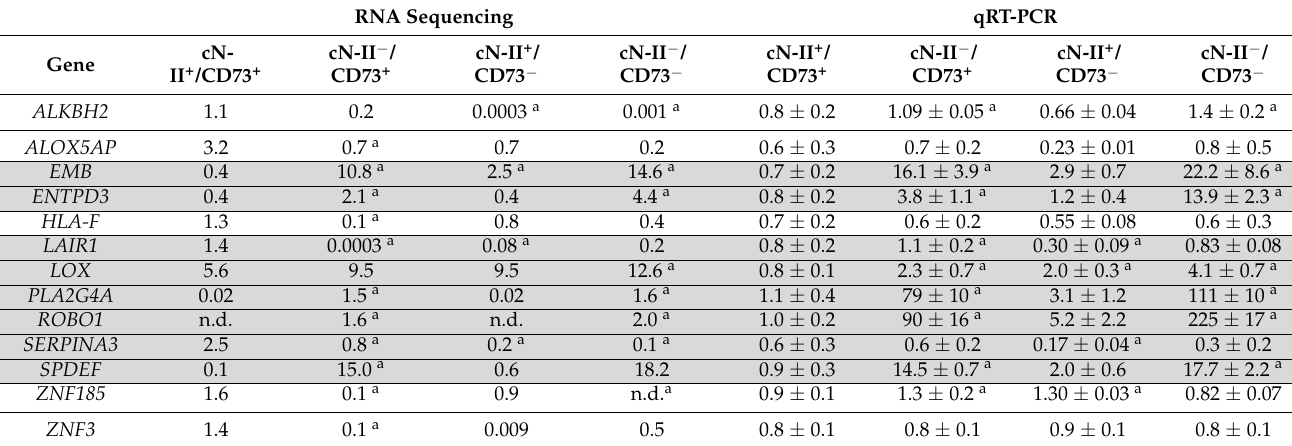
Table 1. Validation of RNA sequencing results by quantitative RT-PCR in unexposed cells. Values for qRT-PCR are means of four different samples ± standard deviation. a : p < 0.05 for comparison to cN-II + /CD73 + cells as determined by Student’s t -test on FKPM values from RNA sequencing or by one-way ANOVA test for quantitative RT-PCR results. Grey lines indicate completely or partially similar results between RNA sequencing and qRT-PCR.